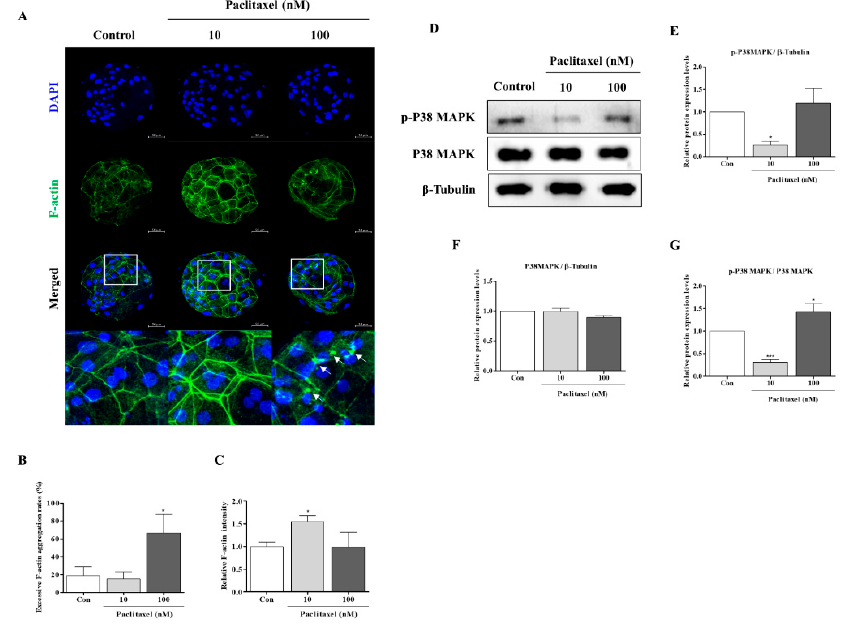
Figure 5. Confirmation of relationship with adhesive junction F-actin enrichment and P38 MAPK activation in developed porcine blastocysts after 10 and 100 nM paclitaxel exposure. ( A – C ) Chang- ing adhesive junction F-actin expression (white arrows) by paclitaxel exposure (10 and 100 nM) at the blastocyst stage in pigs. Fluorescence expression of F-actin (green) and DAPI (blue) in the blas- tocyst stage treated with paclitaxel after IVC. Scale bar = 50 μ m. Data on the bar graph are presented as the mean ± SD of three independent experiments. Differences were considered significant at * p < 0.05 compared to the control group. ( D – G ) Protein levels of P38 MAPK (p-P38 and P38) using Western blotting in developed porcine blastocyst from 10 and 100 nM paclitaxel treated embryos. Relative folds of protein levels were obtained by normalizing the signals to β -tubulin. Blots were probed with phosphorylation-specific antibodies for P38 MAPK and total P38 MAPK. Densitomet- ric analysis was done by normalizing phosphorylated P38 MAPK to total levels of P38 MAPK. His- tograms represent the values of densitometry analysis obtained using ImageJ software. Data in the bar graph are presented as the means ± SD of three independent experiments (per 50 blastocysts). Differences were considered significant at * p < 0.05, *** p < 0.001 compared to the control group.